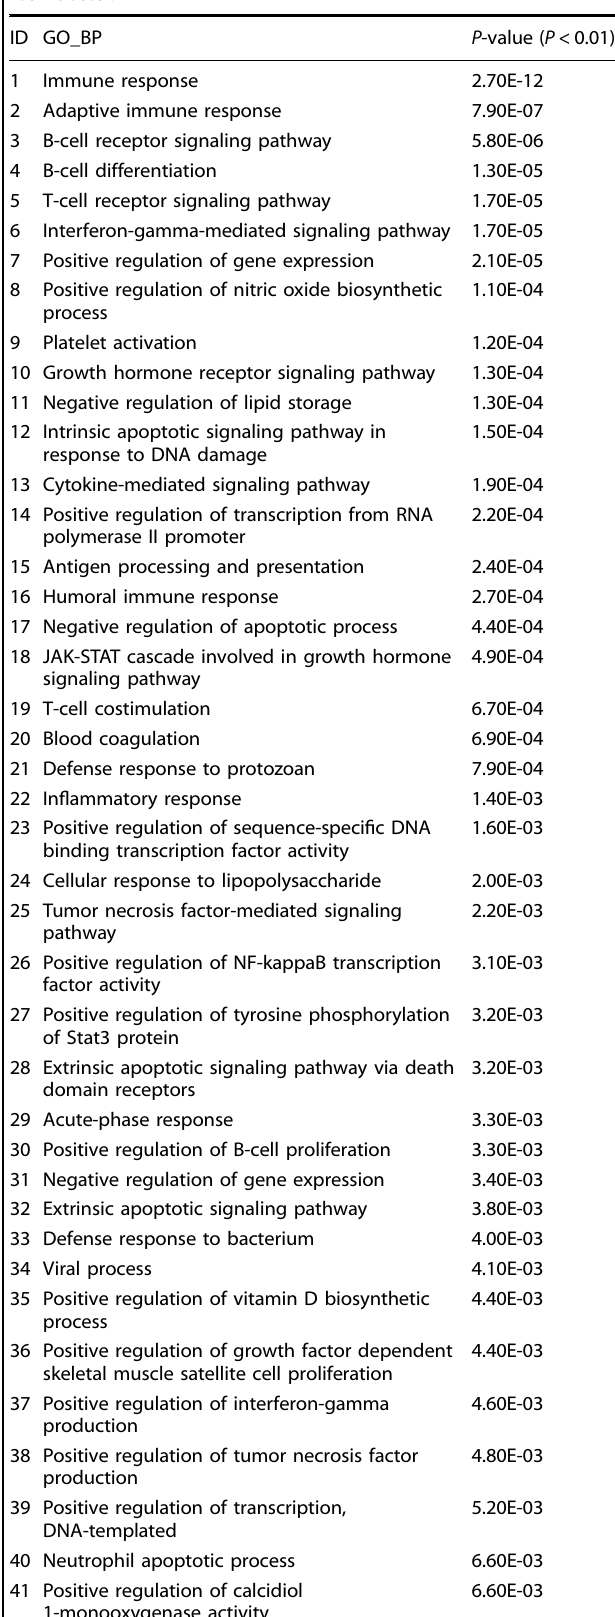
Table 4. The GO BP of overlapping genes enriched of insomnia-fever- rash